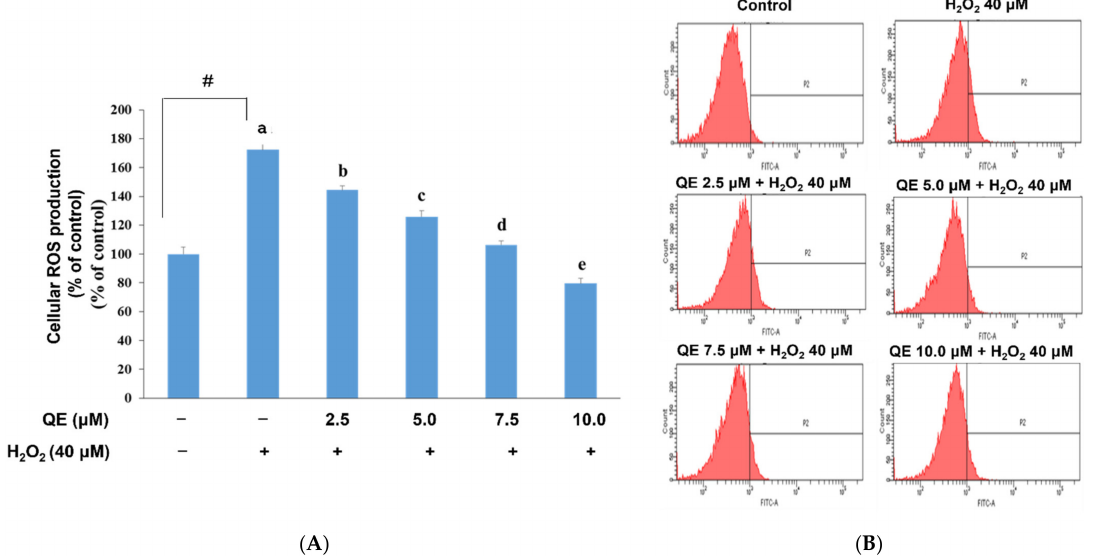
Figure 1. Effects of quercetin on the cellular ROS production following H 2 O 2 -induced oxidative stress in the SH-SY5Y cells. ( A ) Quantitative results of the ROS production in each group according to ( B ). Representative profiles of the ROS production detected by flow cytometry using DCF-DA assay. The SH-SY5Y cells were incubated with 40 µ M H 2 O 2 for 24 h after the addition of 0, 2.5, 5.0, 7.5, and 10.0 µ M quercetin for 24 h. Data were presented as mean ± SD. # Data are analyzed using an independent t -test and are significantly different from the control group. Bars of 0, 2.5, 5.0, 7.5, and 10.0 µ M quercetin with different letters significantly differ. Statistical analysis was performed using a one-way ANOVA, followed by a least significant difference post hoc test ( n = 3).